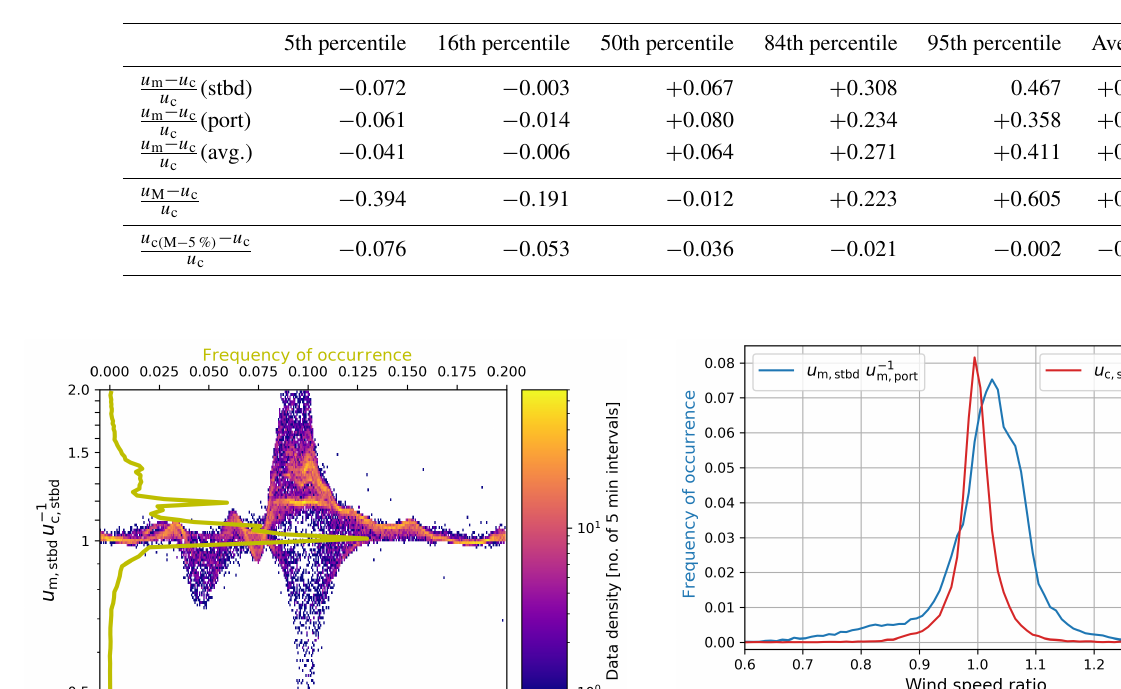
Table 1. Rows one to three show the percentiles of the relative bias between the uncorrected and corrected true wind speed for the respective starboard and port anemometers as well as for the vector average of the measurements from both sensors. Row four shows the percentiles of the relative bias between ERA-5 and the corrected true wind speed. Row five is the same as row four but shows the relative difference between u c and u c ( M − 5% ) that was derived from ERA-5 wind speeds, which were modified to a 5% lower magnitude, in order to test the sensitivity of the correction to a bias in ERA-5. Values provided are for u c > 2ms − 1 .